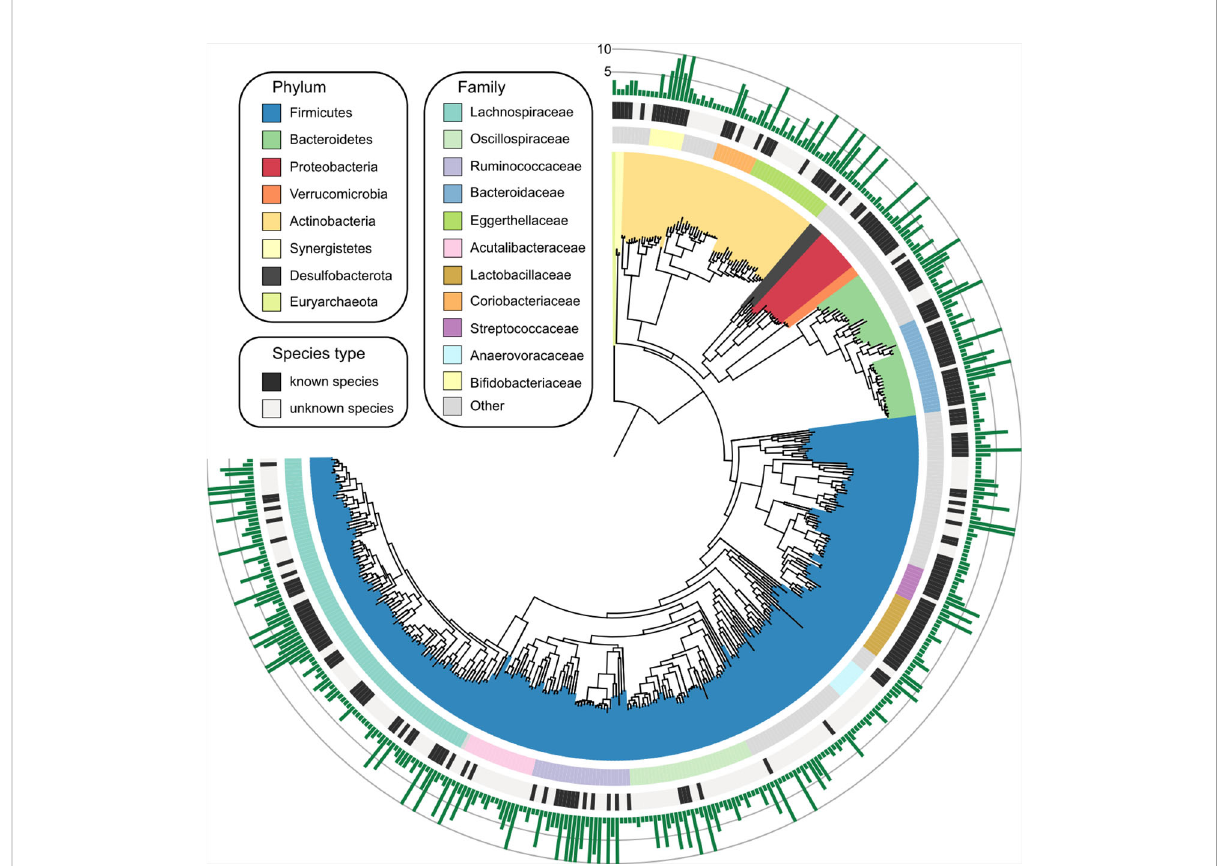
FIGURE 1 Genome-wide representation of 406 prokaryotic species. The innermost circle: phylogenetic tree analysis of 406 species based on their genome sequences. The colors in the tree indicate the phylum-level taxonomic assignment of the species. Circle 2: taxonomic assignment of the species at the family level. Circle 3: the species that could be assigned into known species are labeled in black, and the remaining species are uncultivated. Outermost circle, the number of MAGs for each species. Species with more than 10 MAGs were cropped into 10 for visual clarity, and the detailed information of all species was listed in Table